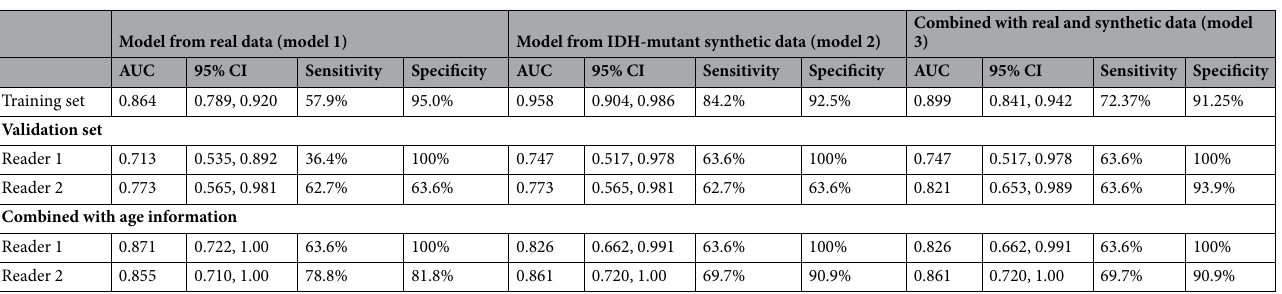
Table 3. Diagnostic performance of the models for prediction of IDH mutation. AUC area under the receiver operating characteristics